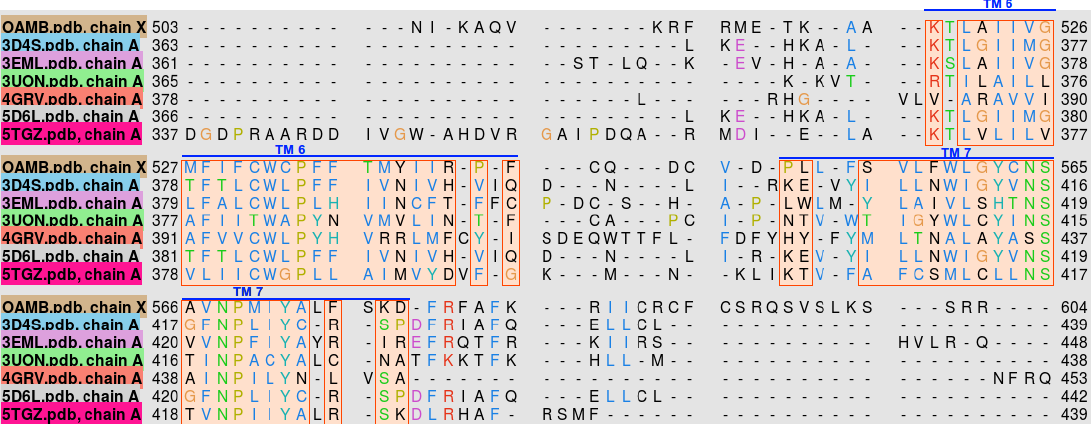
Figure 2. Transmembrane helix sequence alignment of Drosophila melanogaster OAMB and the top templates used in the homology modeling. Helix numbers are specified by the